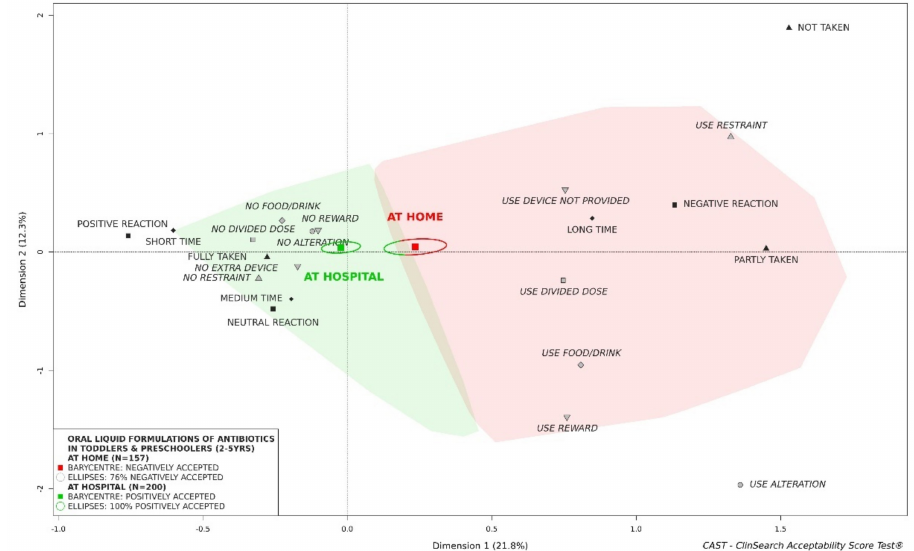
Figure 5. Acceptability of oral liquid formulations of antibiotics in toddlers and preschoolers depend- ing on place of